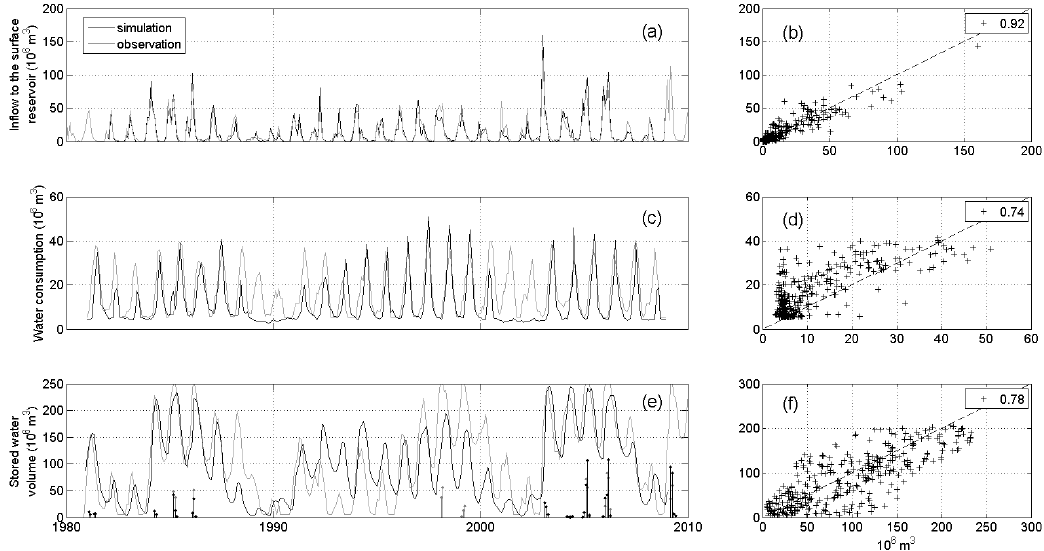
Figure 3. Model validation. Panel ( a ): observed and simulated inflow to reservoir. Panel ( b ): scatter plot and monthly correlation of observed and simulated inflow to reservoir (in legend). Panel ( c ): observed and simulated water consumption. Panel ( d ): scatter plot and monthly correlation of observed and simulated water consumption (in legend). Panel ( e ): observed and simulated stored water volume and overflow (full lines and stems respectively). Panel ( f ): scatter plot and monthly correlation of observed and simulated stored water volume and overflow (in legend).